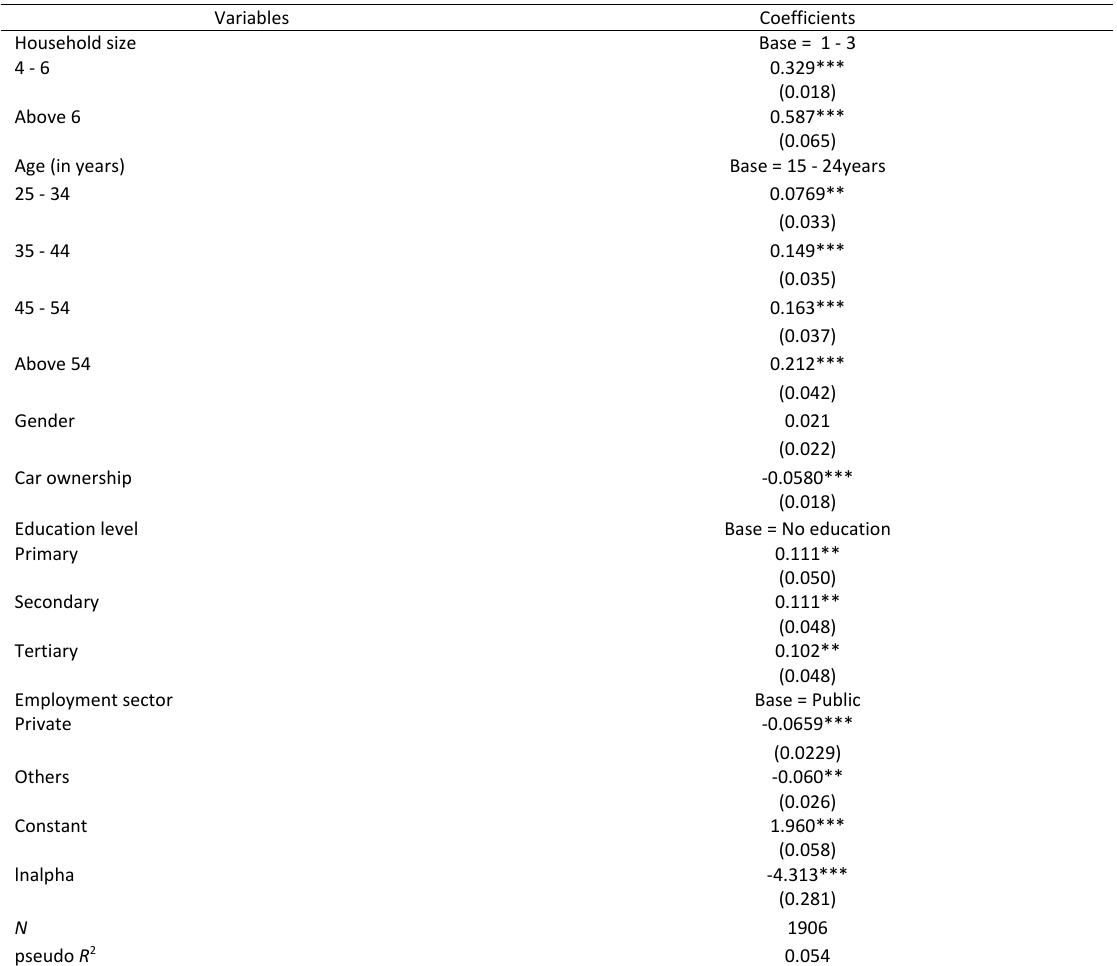
Table 5: Negative binomial regression results of travel demand using trip volume as a measure with categorized household size and age of the household head